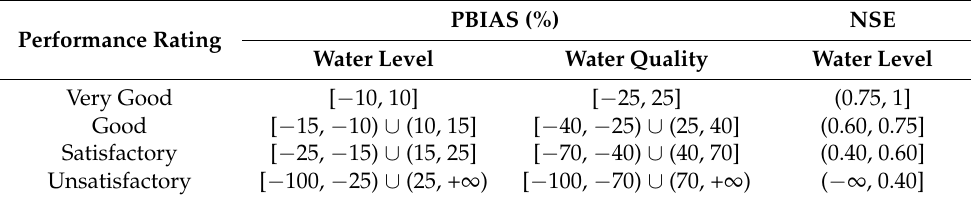
Table 5. General performance ratings for recommended